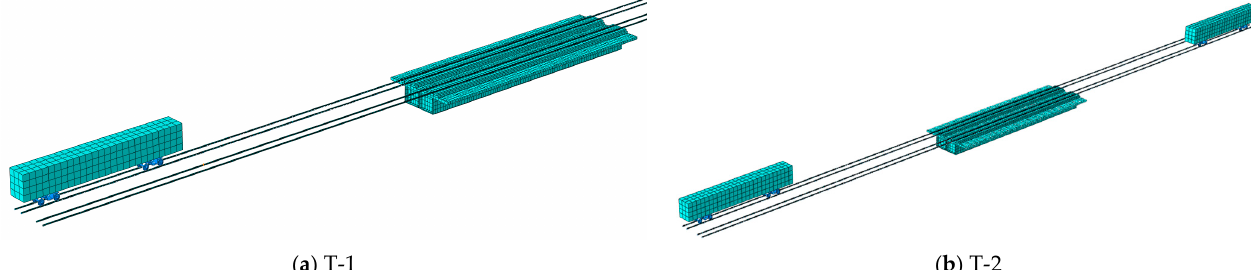
Figure 22. Train–track–composite beam under the 2 driving